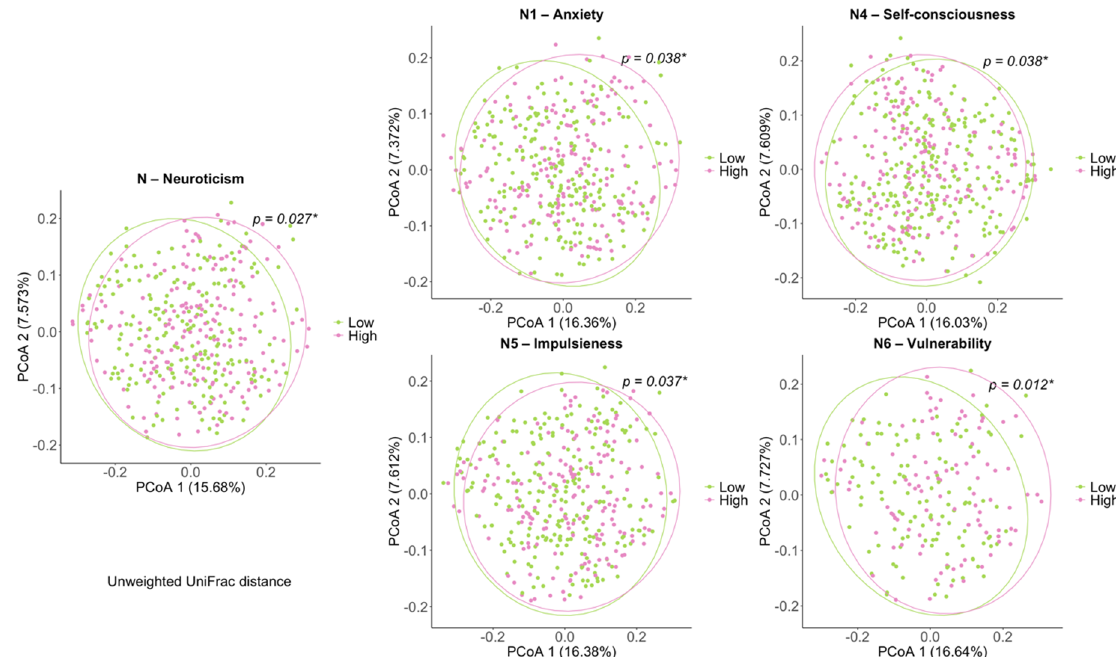
Figure 3. Principal Coordinate Analysis (PCoA) plots of beta diversity. Statistical significance between Low and High groups using distance matrices for beta–diversity Unweighted UniFrac distance. Statistics were calculated using pairwise PERMANOVA with 999 permutations. * p < 0.05. Ellipses represent 95% confidence interval for each group.